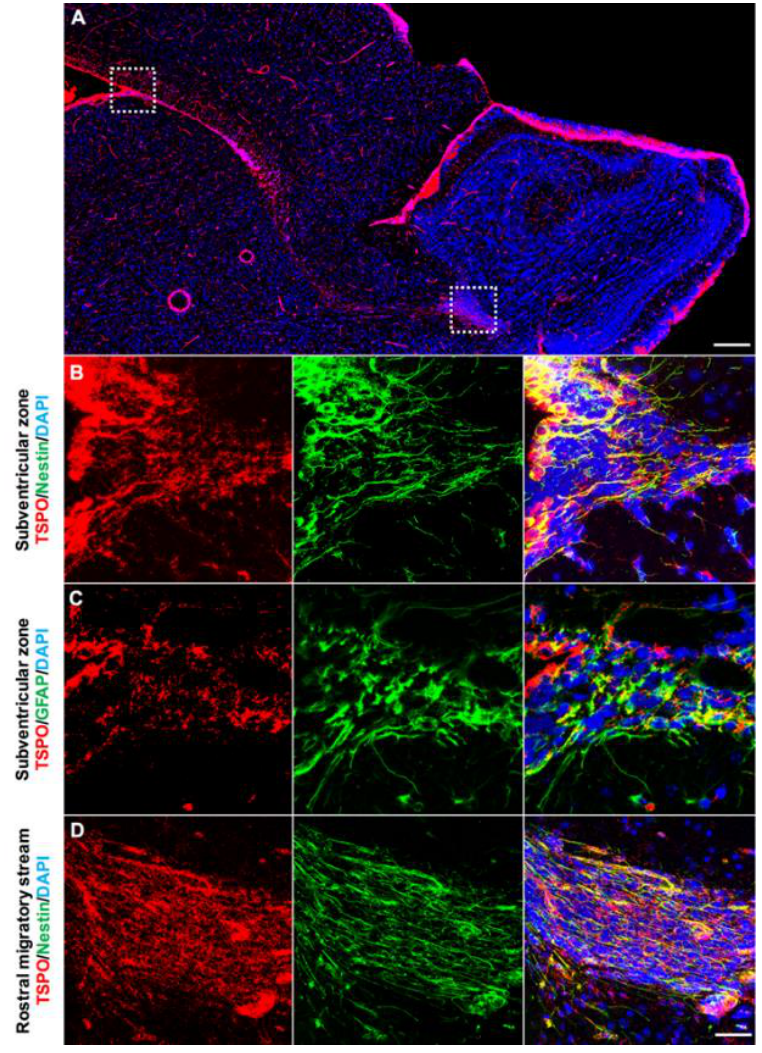
Figure 4. TSPO is expressed in the neurogenic regions of the subventricular zone and the rostral migratory stream (RMS). ( A ) Strong TSPO immunofluorescence (red) is observed in the subventricular zone adjacent to the ependymal lining of the ventricles, and extends through the RMS to the neurogenic niche of the olfactory bulb. ( B ) TSPO expression (red) is observed in Nestin+ neural stem/progenitor cells (green) in the subventricular zone (sagittal view). ( C ) In the RMS, TSPO expression in Nestin+ progenitor cells (green) is also high (sagittal view). ( D ) TSPO expression (red) also colocalizes with GFAP in neural stem/progenitor cells (green) in the subventricular zone (coronal view), confirming the presence of TSPO in neural stem/progenitor cells. Scale bars = 300 µm for ( A ), 20 µm for ( B – D ).